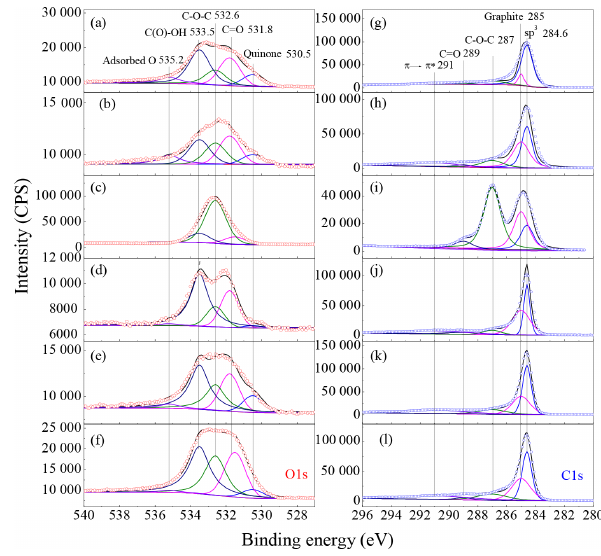
Figure 4. XPS spectra of carbon nanomaterials. (a) – (f) are O1s spectra and (g) – (l) are C1s spectra for SB4A, graphene, graphene oxide, SWCNT, SWCNT-OH and SWCNT-COOH,